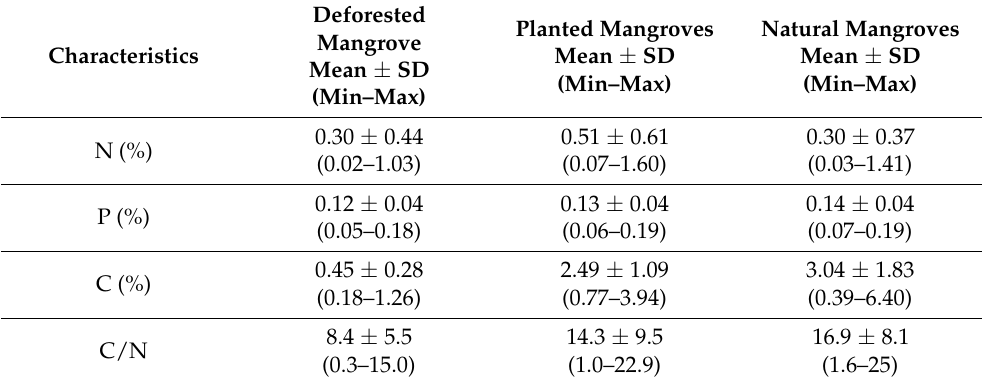
Table 3. Characteristics of sediments in different